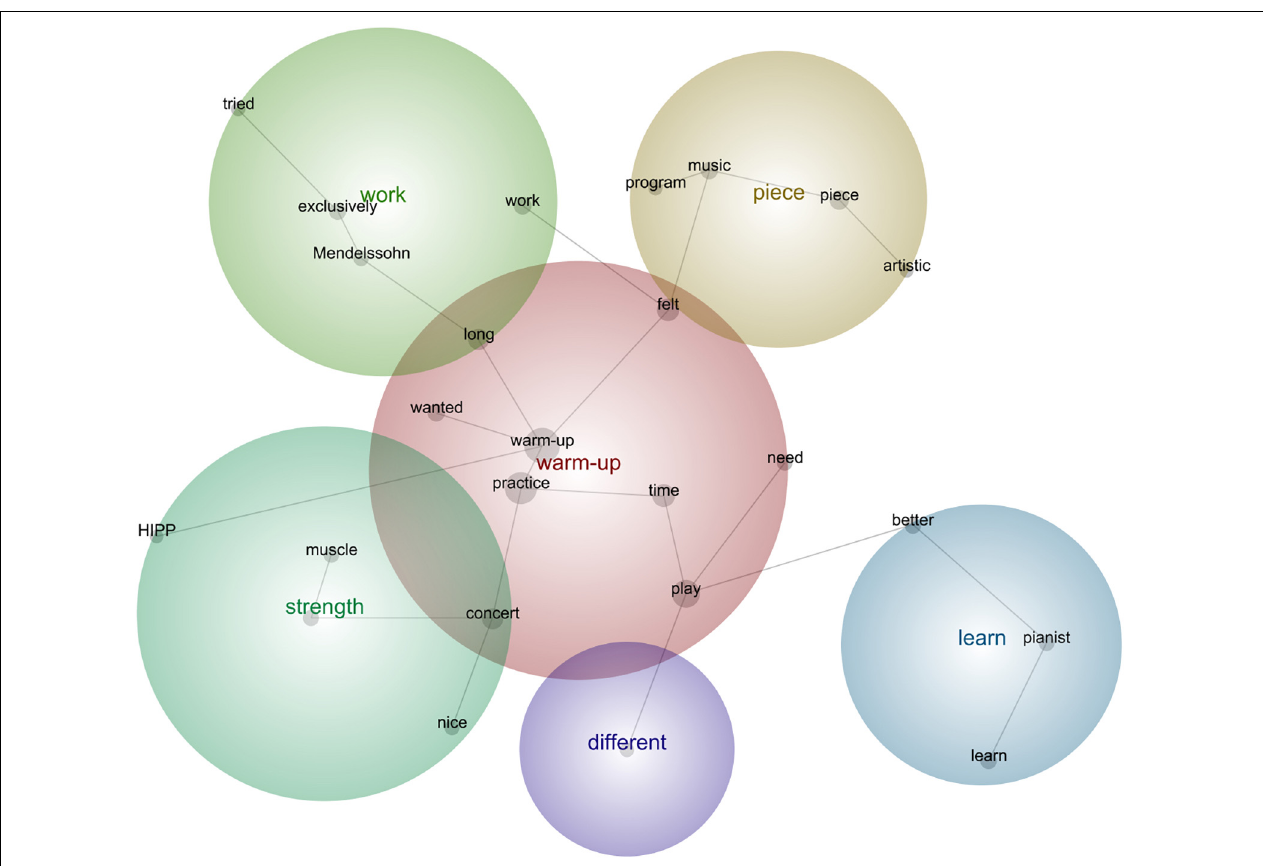
FIGURE 8 | Leximancer concept map for Concert